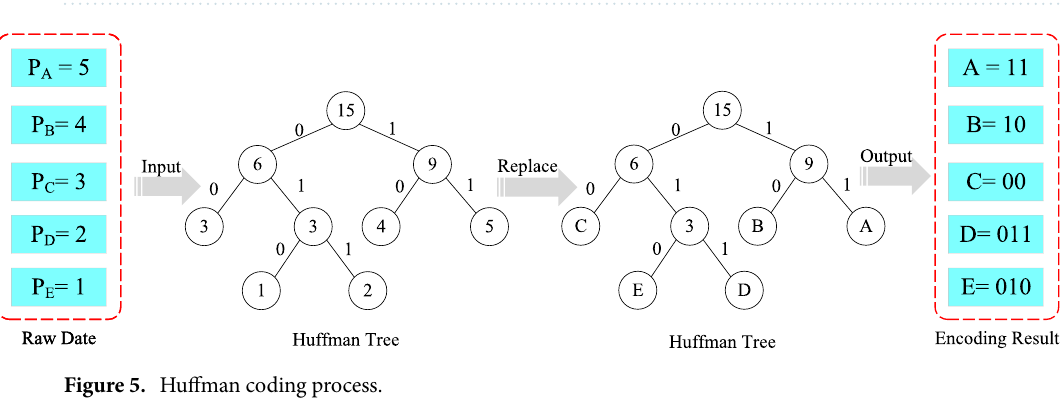
Figure 4. ( a ) Bifurcation diagrams of the SCL maps; ( b ) Sequence comparison before and after y 0 ( 0 ) perturbation.